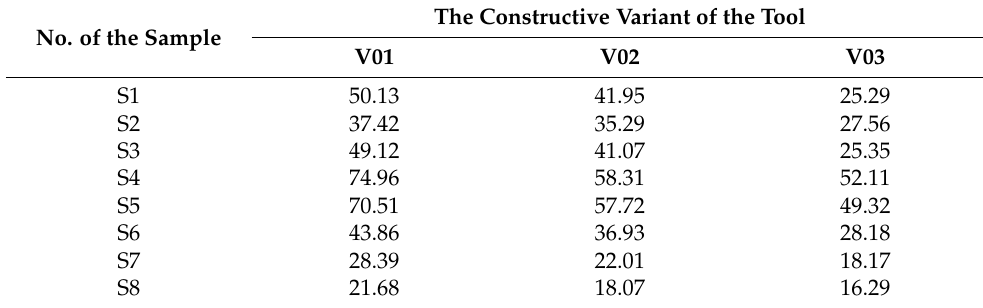
Table 5. The medium values of F f component for the 3 variants of cutting tools, daN. No. of the Sample